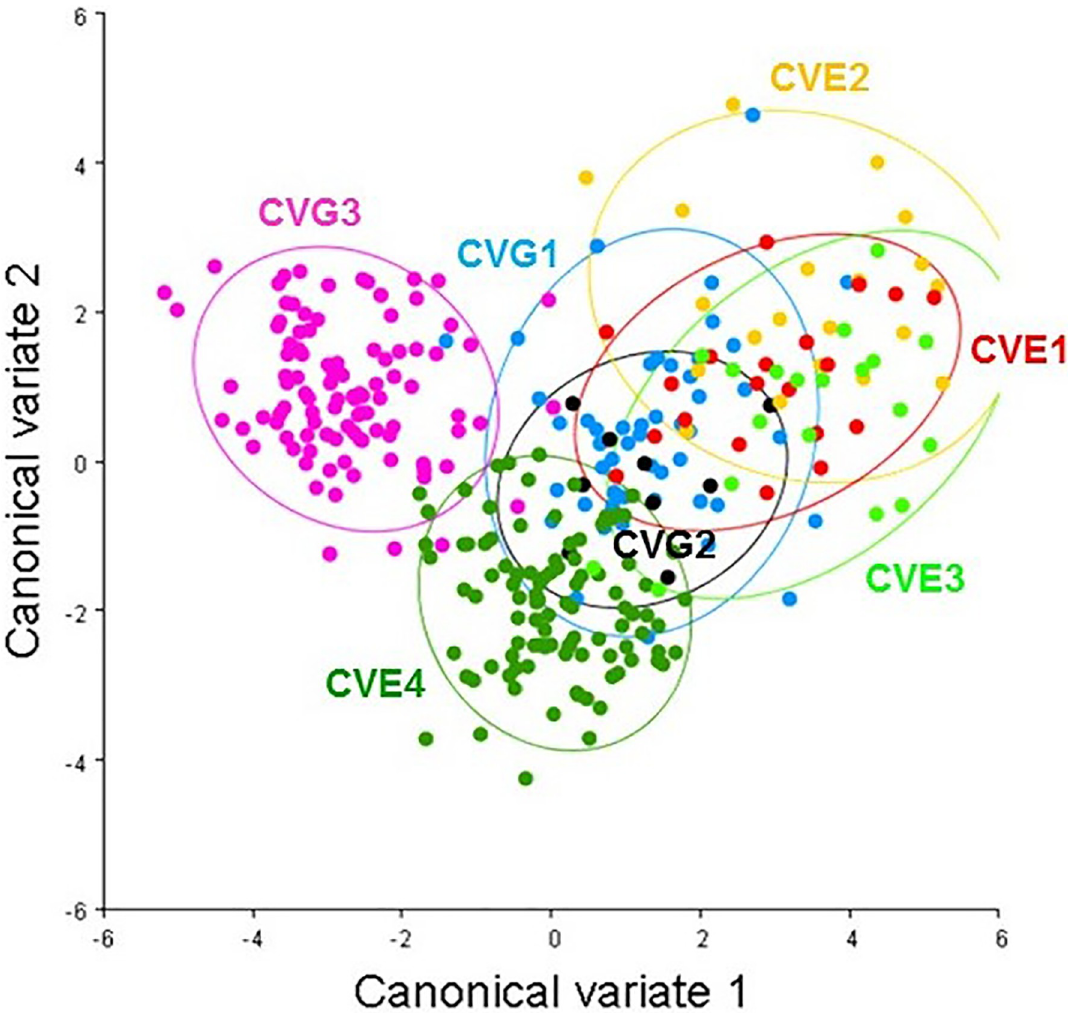
Fig 8. Scatter plot showing the distribution shape variable of C . vicina in each population along the first two canonical variant analysis (CV1 = 58.25%, CV2 = 23.24%) with 90% confidence ellipses; 7 locations representing as follow: Germany (CVG1, CVG2, CVG3), England (CVE1, CVE2, CVE3, CVE4).